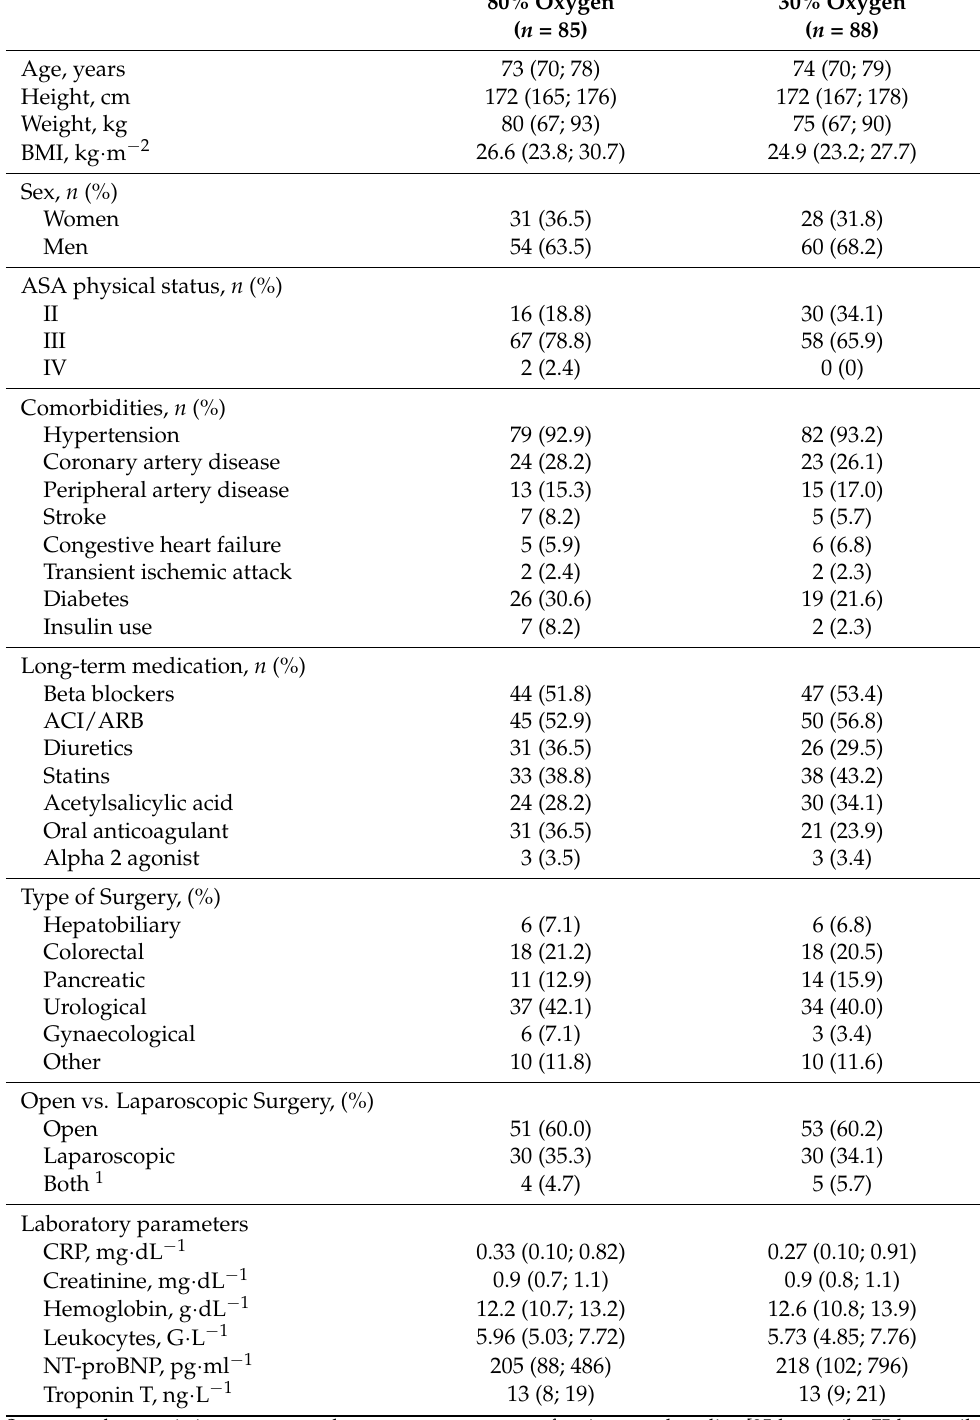
Table 1. Patient